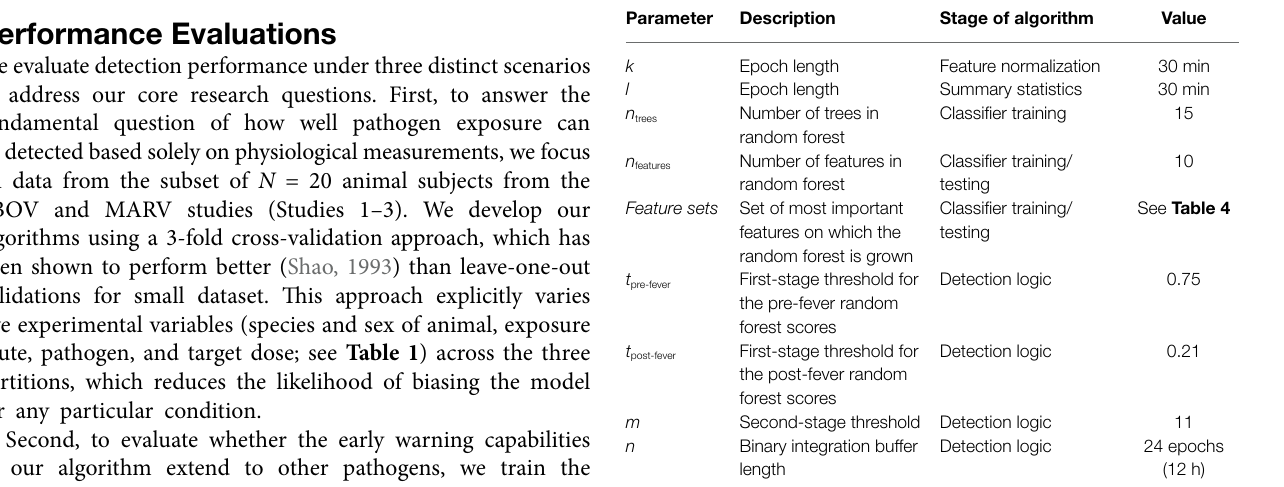
TABLE 3 | Algorithm